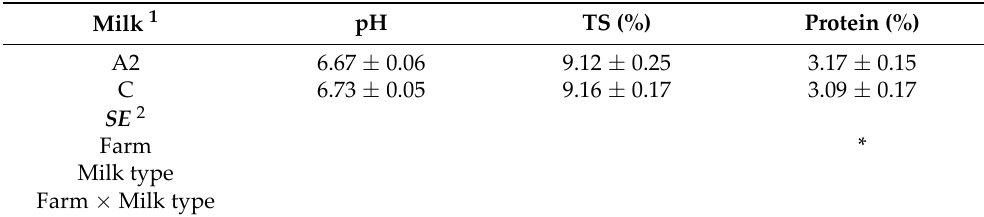
Table 3. Chemical composition of milks.